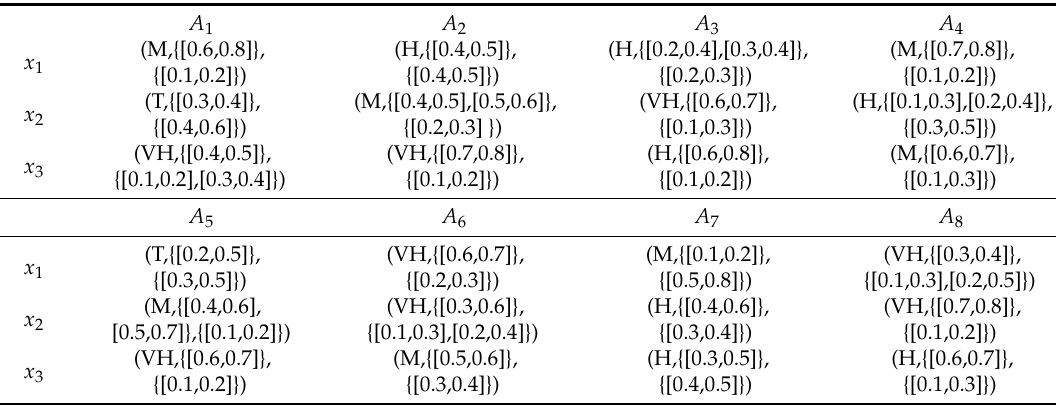
Table 4. The IVDHFUBL decision matrix R 3 provided by decision-maker E 3